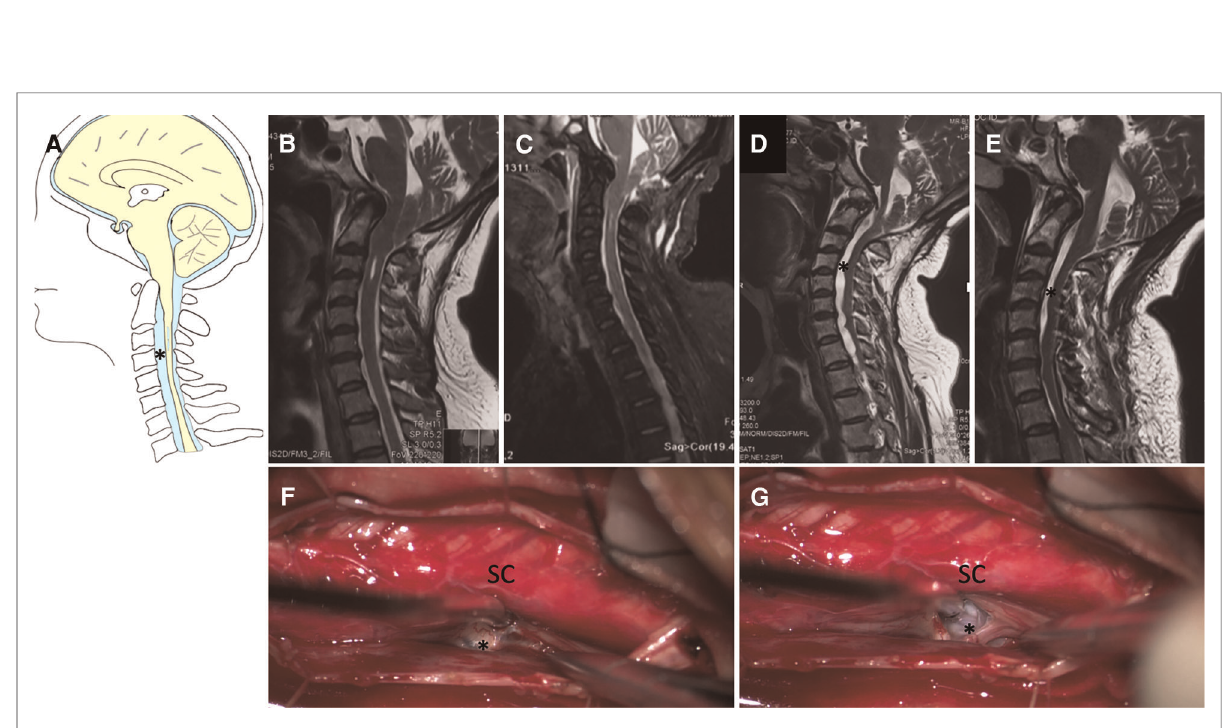
FIGURE 6 Case presentation of ventral cyst of spinal cord in Group III, ( A ) schematic drawings of the cervical spine, sagittal view. ( B ) Preoperative sagittal T2- weighted MRI showed small syringomyelia. ( C ) 2 weeks, ( D ) 3 months later after the fi rst surgery MRI showed partial bone defects of posterior inferior border of occipital bone, ventral cyst of spinal cord. ( E ) Postoperative MRI after second surgery showed obvious reduction of cyst. Under electrophysiological monitoring, the cyst was incised and drained ( F,G ). SC, spinal cord. Asterisk: Ventral